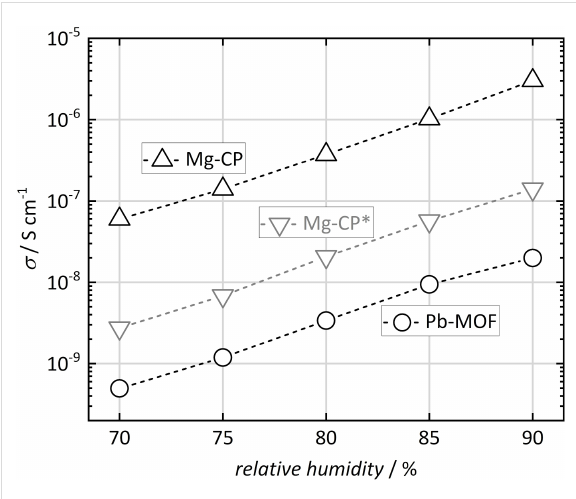
Figure 3: Proton conductivity (dashed lines as a guide to the eye) of [Mg(H 2 O) 2 (H 3 L)]·H 2 O (Mg-CP) and [Pb 2 (HL)]·H 2 O (Pb-MOF) at vari- able relative humidity (22 °C, before thermal activation). *The lower values for Mg-CP (gray) correspond to the conduction mode that is irreversibly erased by thermal activation.